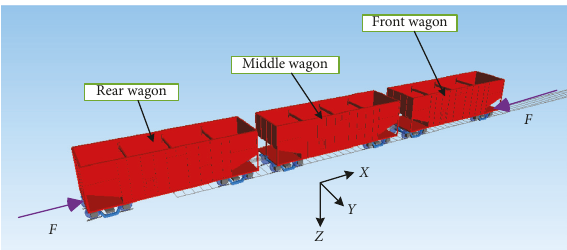
Figure 7: Dynamic model of the